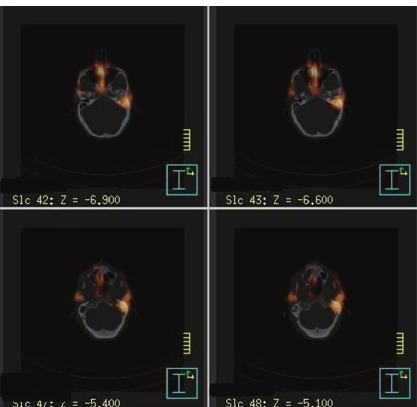
Figure 2: SPECT scan demonstrating increased areas of uptake in the region of the left petrous temporal bone and external auditory canal.